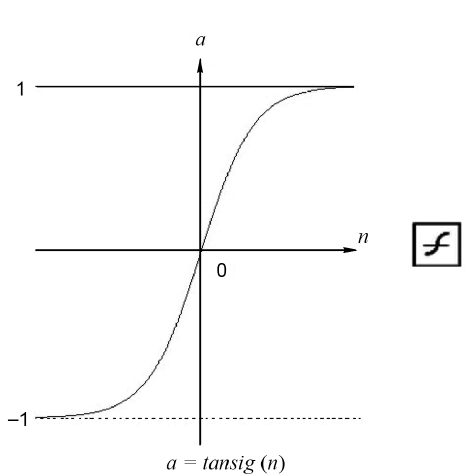
2 and the slope of fitting